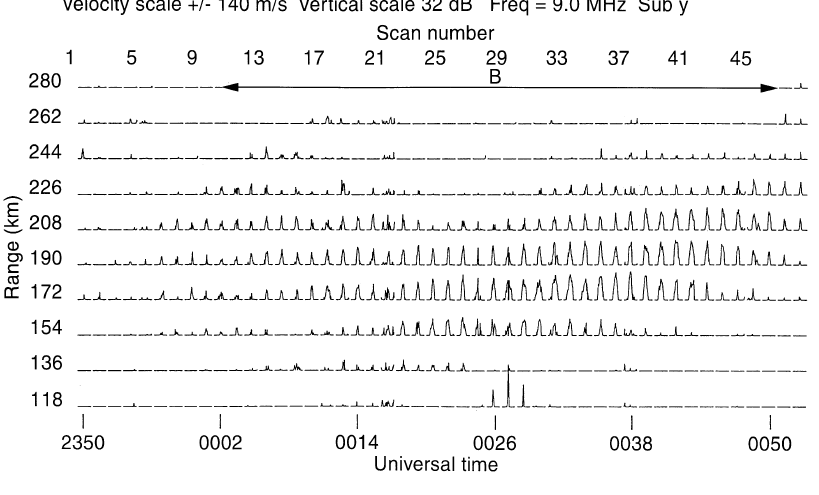
Fig. 10. Time evolution of E-region magnetic aspect sensitive echoes at 9 MHz in azimuth 10 (cid:176) W, in the time-period 2350–0053 UT. The Doppler spectrum at any cell is logarithmic on a 32-dB scale with the Doppler velocity ranging from ) 140 to 140 m/s. The range of the scattering region varies with time and seems to show a